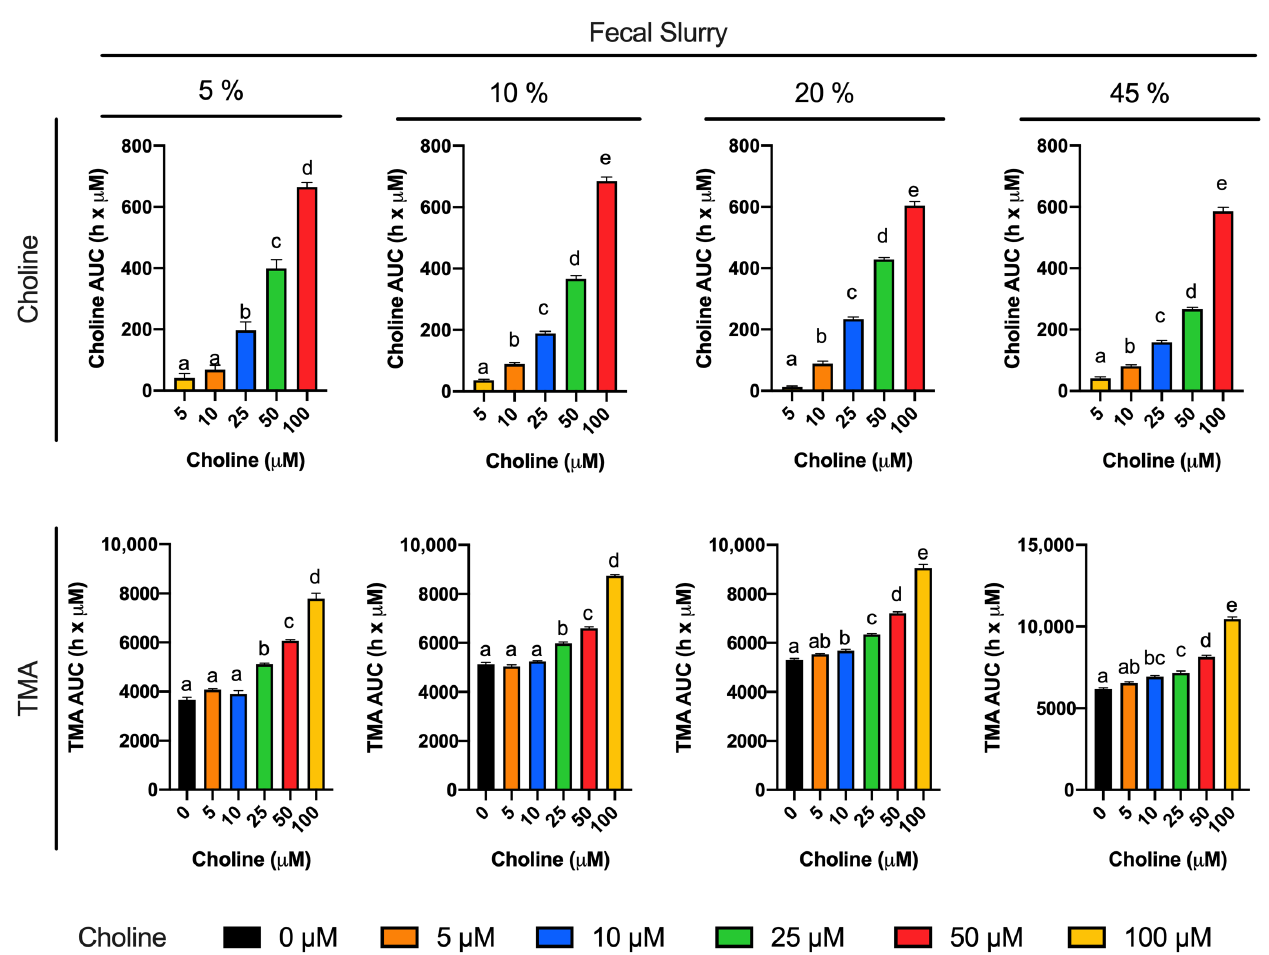
Figure 2. Areas under the curve (AUC) of choline ( top ) and TMA ( bottom ) kinetic curves obtained by fermenting choline (0–100 µ M) with different percentages of fecal slurry (5–45%). For choline AUCs, time-matched choline concentrations in the background (0 µ M choline) are subtracted from choline-supplemented conditions (values for 0 µ M choline AUCs are thus 0, and not shown). Results are expressed as mean (h x µ M of choline or TMA) ± SEM ( n = 3). Different letters indicate statistical differences ( p < 0.05) by one-way ANOVA (Tukey’s post hoc test). TMA levels at 0 µ M choline were not detected, and thus, have not been included for